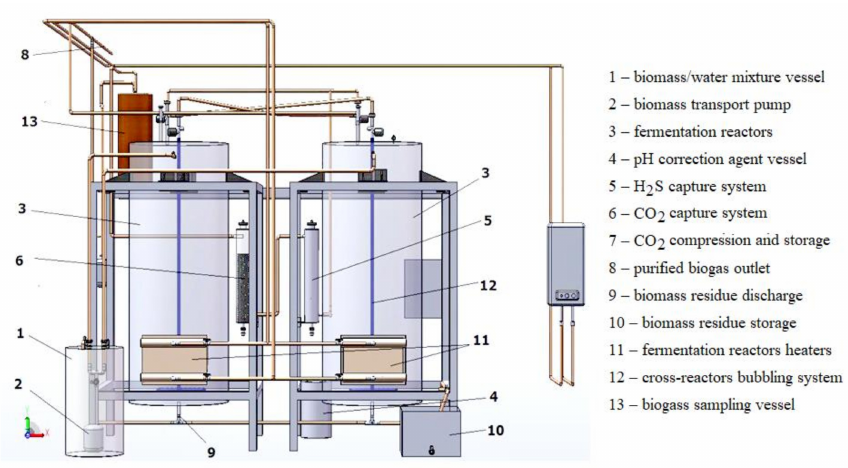
Figure 3. Schematic of the 6 m 3 (2 × 3 m 3 ) biogas pilot